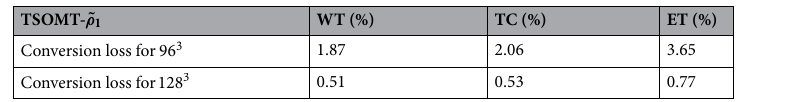
Table 2. Conversion loss between brains and cubes with grid sizes of 96 3 and 128 3 ,